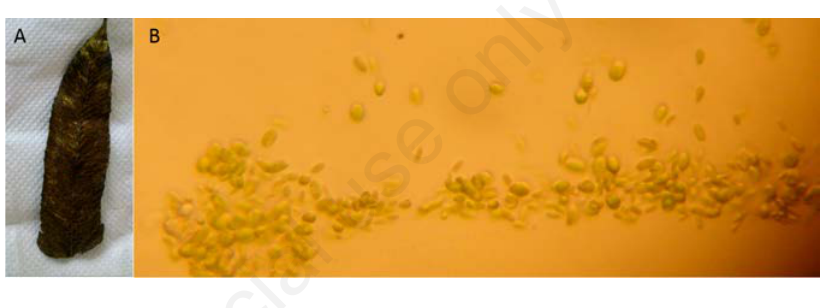
Figure 1. Diplazium proliferum: A) mature leaves with Sporangia clusters on back of leaves; B) cells at gametophytic stage viewed under compound microscope.